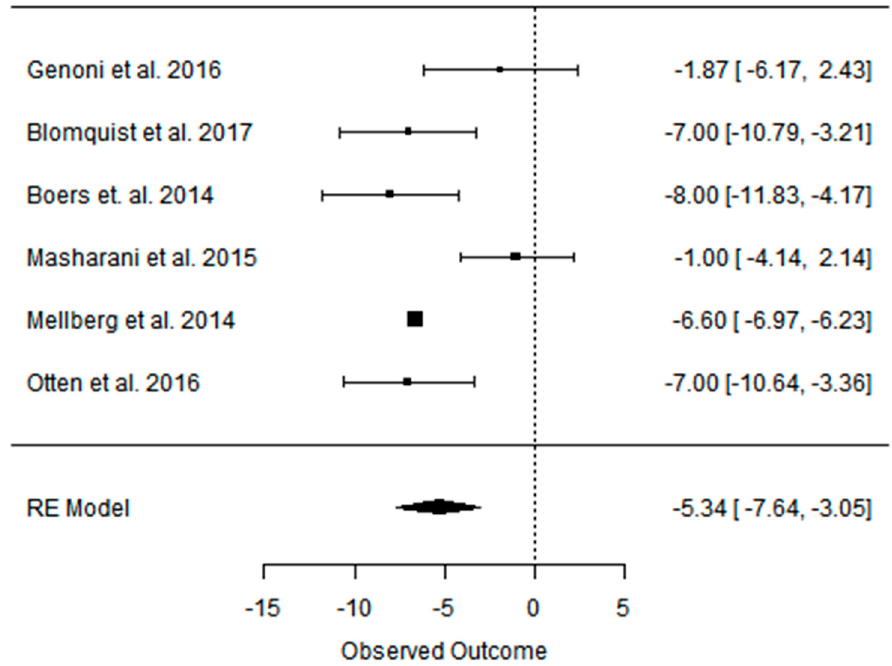
Figure A38. Forest plot of the effect of PD on DBP in the short term (weighted mean difference).